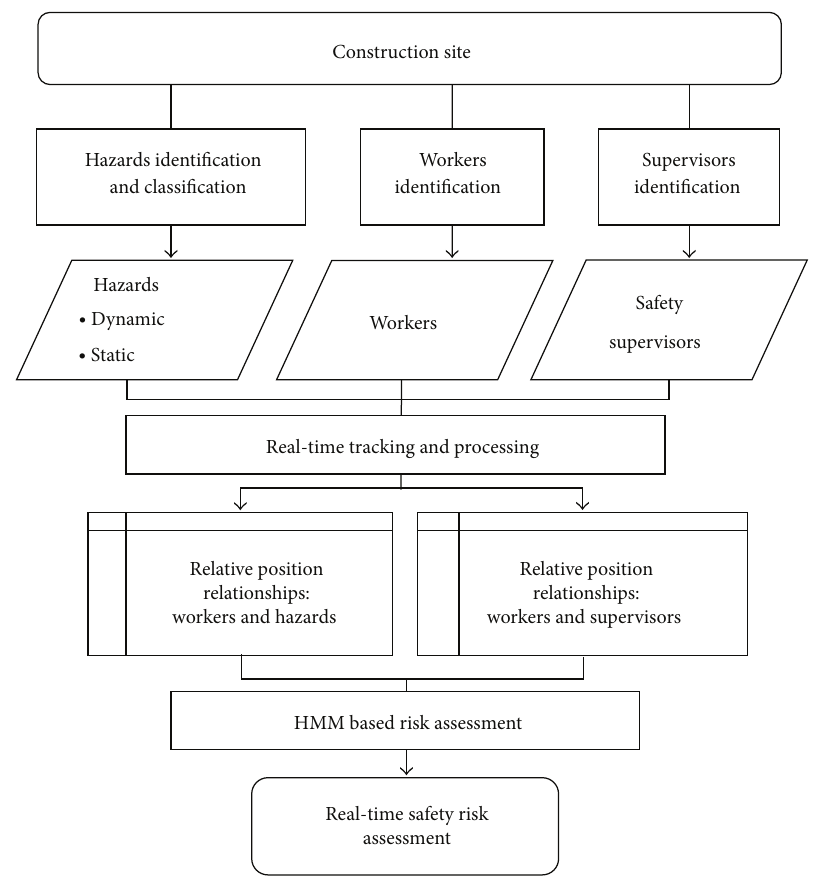
Figure 1: Logic of the real-time safety assessment